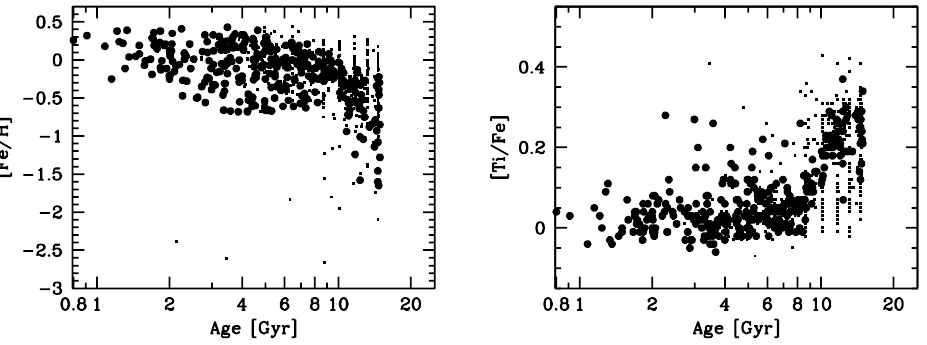
Figure 3. [Fe/H] and [Ti/Fe] versus age. Stars with well-determined ages (difference between upper and lower age estimate less than 3Gyr) are marked by larger